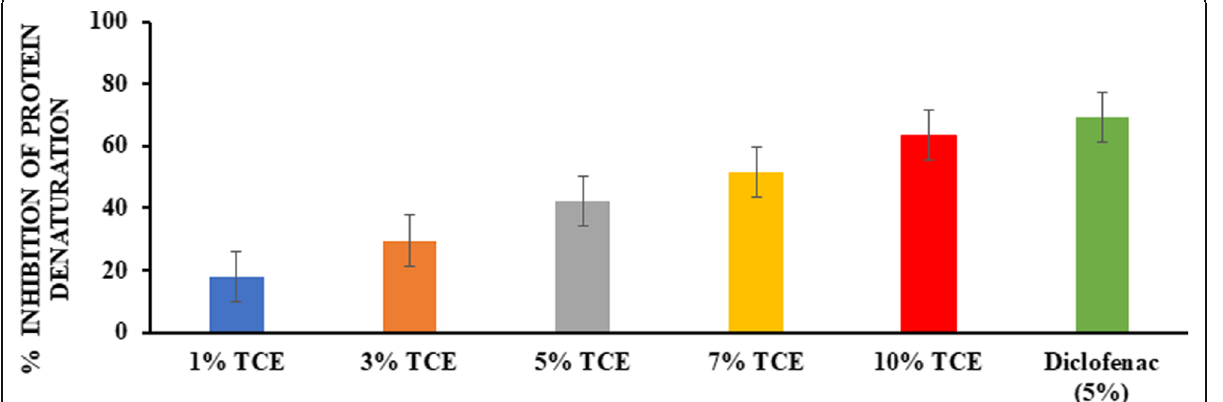
Fig. 4 Percentage inhibition of protein denaturation of the TCE samples relative to Diclofenac